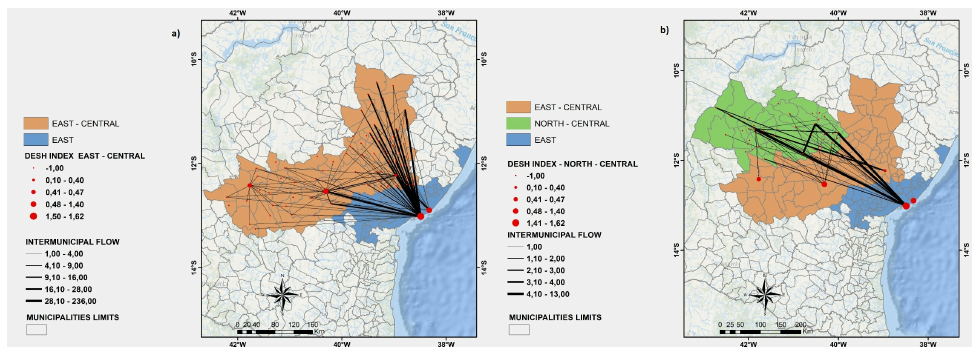
Figure 3. ( a ) A visualization of the East and East-Central regions. ( b ) A visualization of the East, East-Central, and North-Central regions. Source: